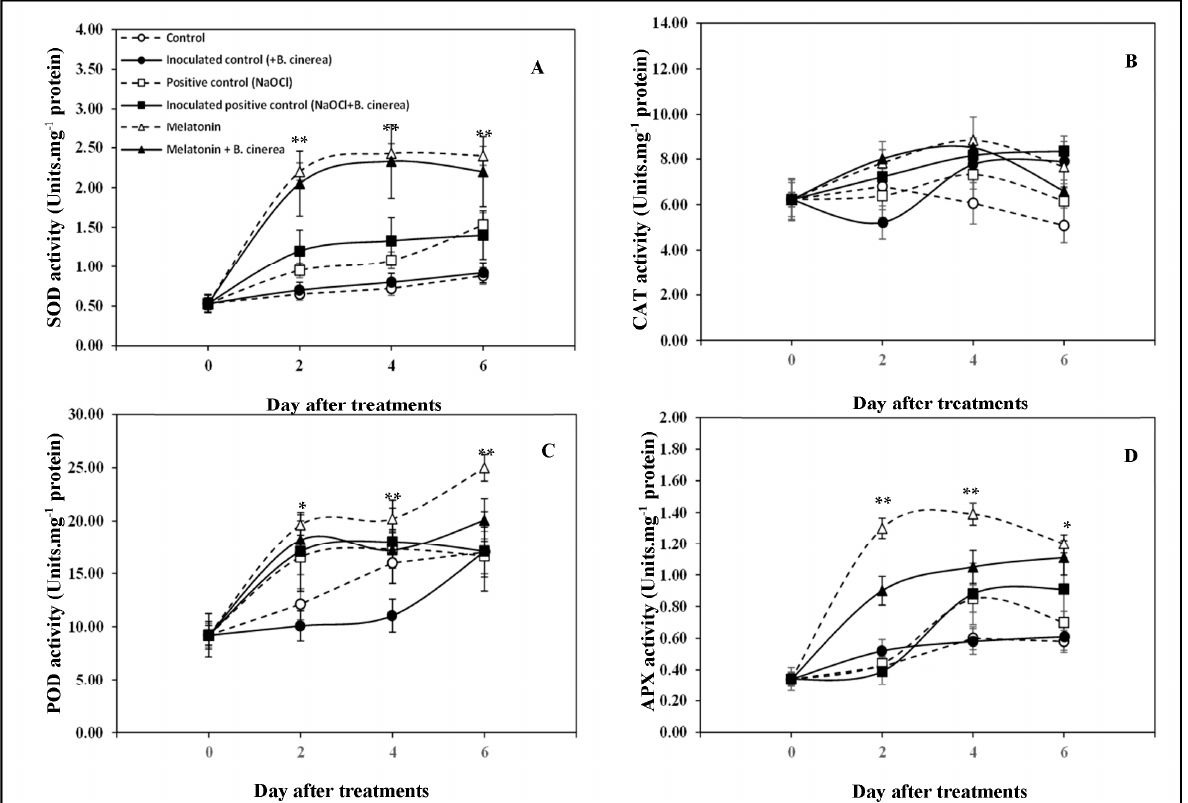
Figure 6. SOD ( A ), CAT ( B ), POD ( C ), and APX ( D ) activity of the strawberry fruits treated with exogenous melatonin and inoculated with and without Botrytis cinerea during storage at room temperature (25 ± 2 ◦ C, 80–85% RH) for 6 days. Data are the means ± S.D. of three replications (three sets of ten fruits). Significant differences between treatments are indicated with asterisks (** ( p < 0.01); * ( p < 0.05)).